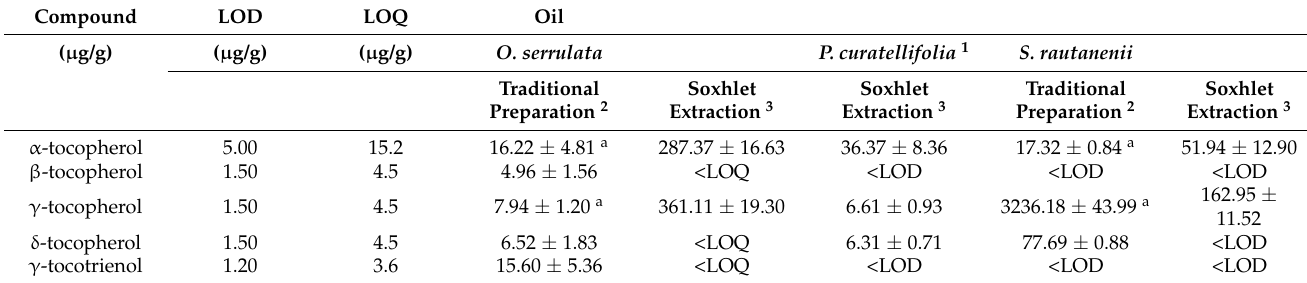
Table 3. Tocopherol and tocotrienol contents of the